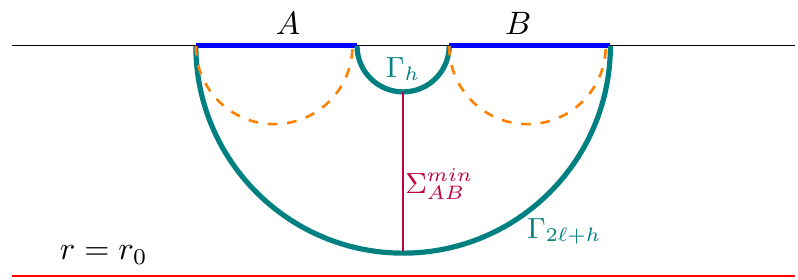
Figure 4 . Schematic con(cid:12)guration for computing E